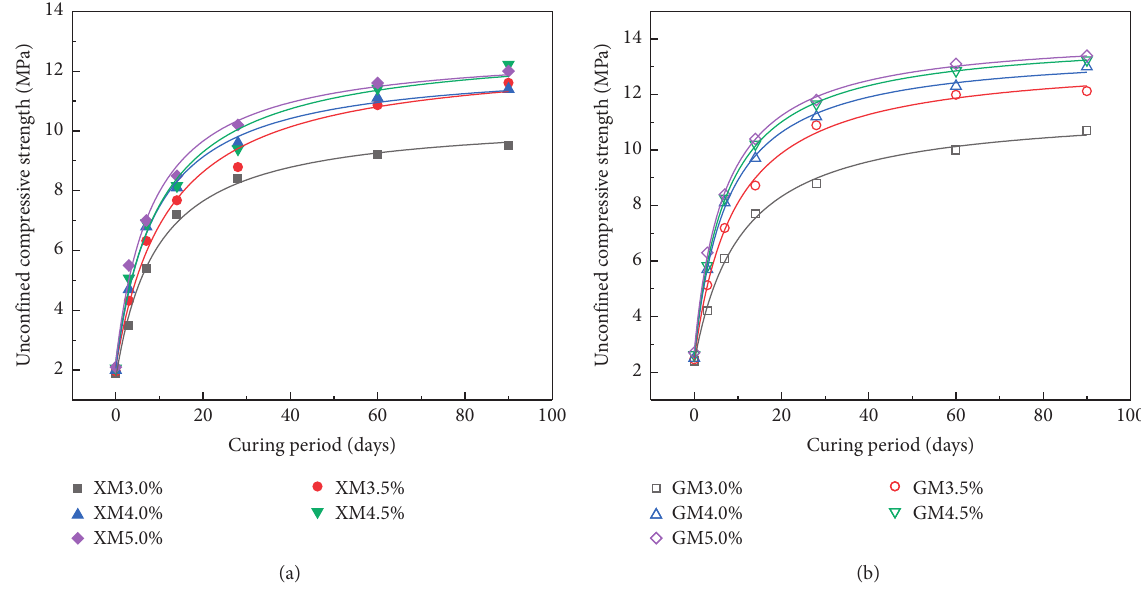
Figure 7: Effect of curing period on unconfined compressive strength. (a) GM gradation; (b) XM